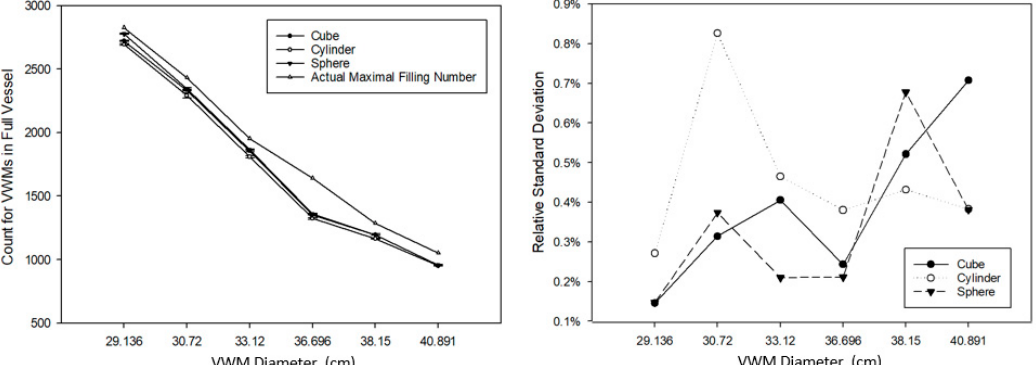
Figure 12. The filling using VWMs for cube (side length = 100 cm), cylinder (diameter = 100 cm, height = 200 cm), and sphere (diameter = 100 cm). ( Left ): The quantity difference between the actual maximal filling number and the filling number with standard deviation. ( Right ): The relative standard deviation for each filling was repeated five times.